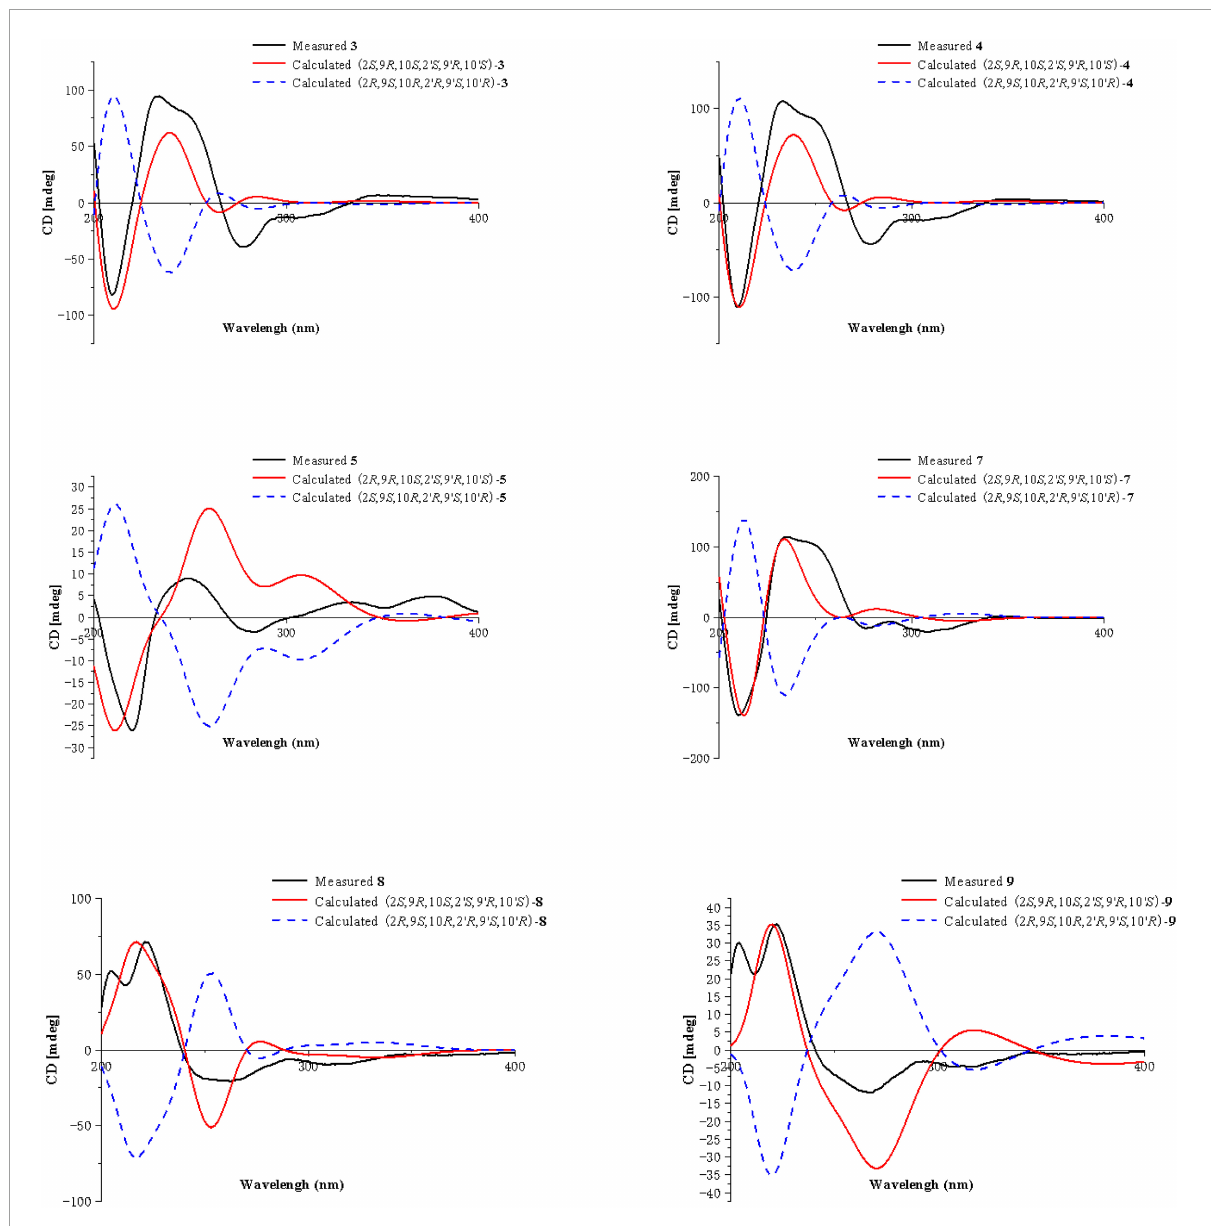
FIGURE4 ECD calculations of 3 , 4 , 5 , 7 , 8, and 9